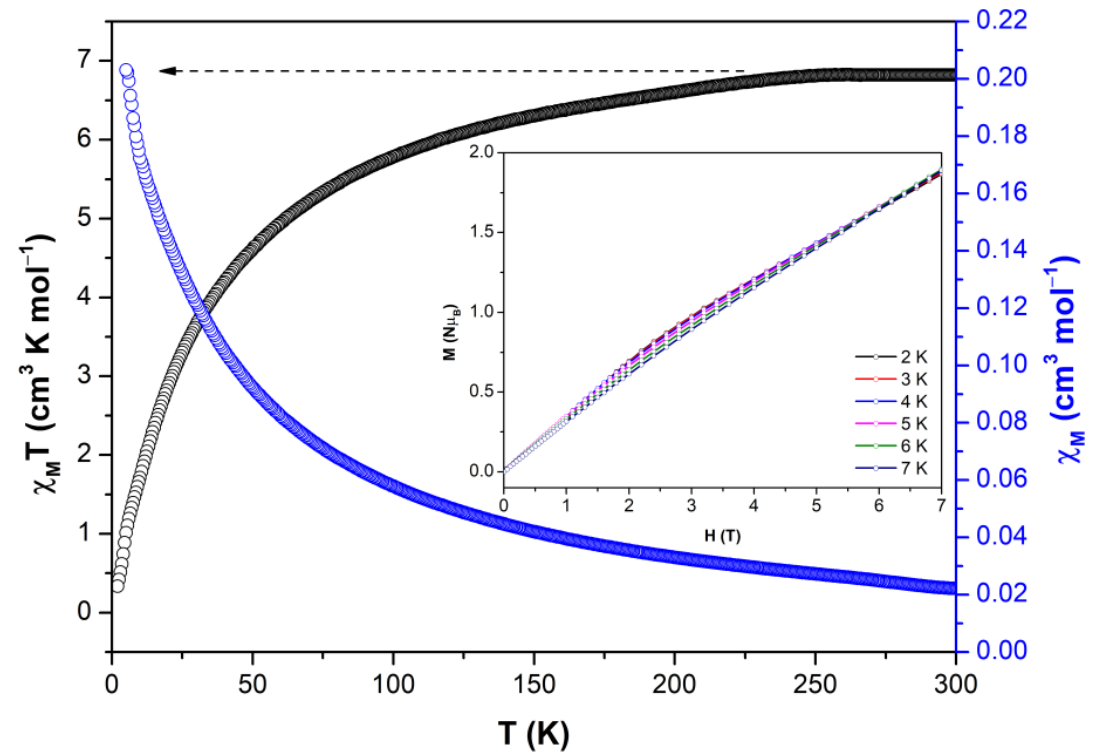
Figure 3. Temperature dependence of the χ M T product at 1000 Oe for Co-MOF Inset: M vs. H for Co-MOF 2–7 K. The lines are a guide to the eye.